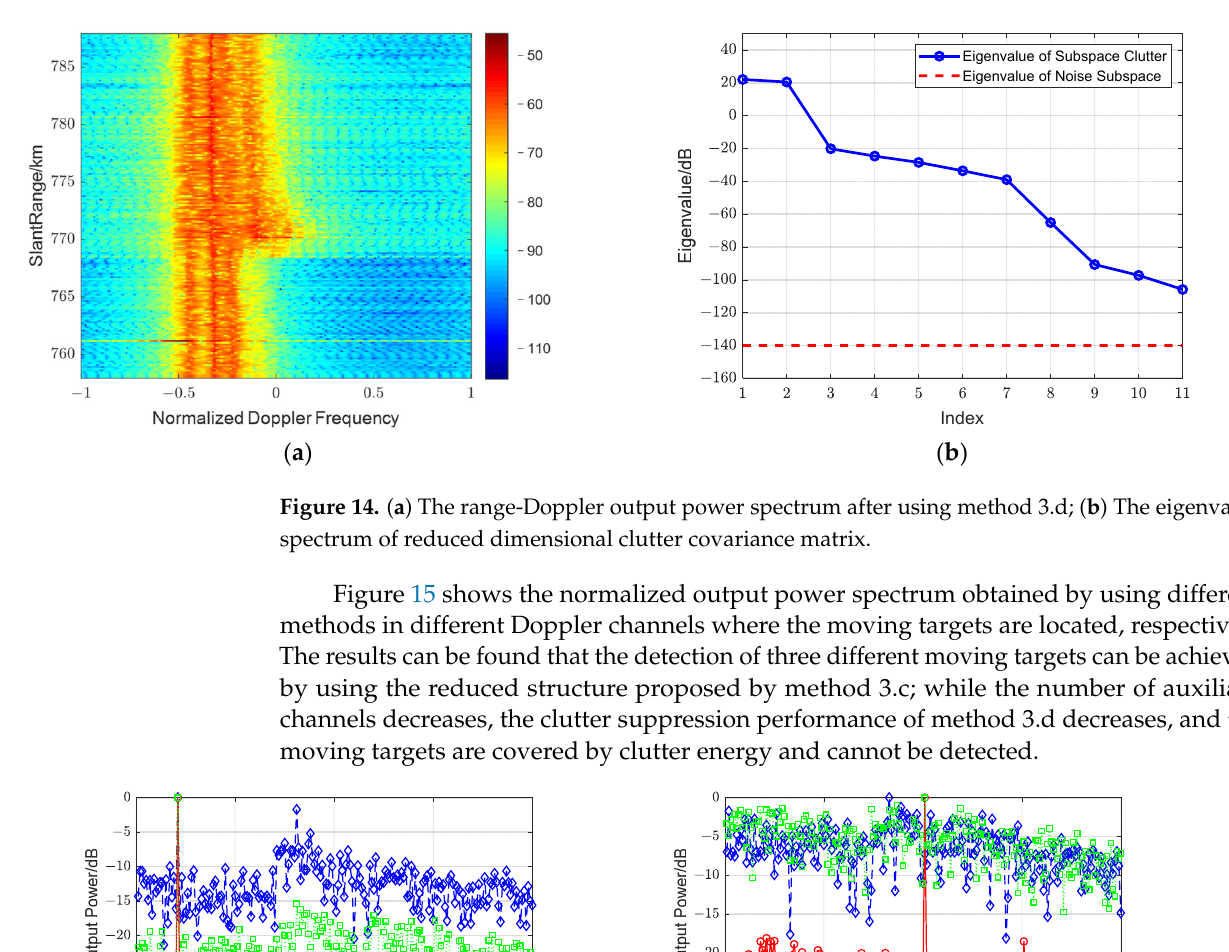
Figure 13. ( a ) The range-Doppler output power spectrum after using method 3.c; ( b ) The eigenvalue spectrum of reduced dimensional clutter covariance matrix.